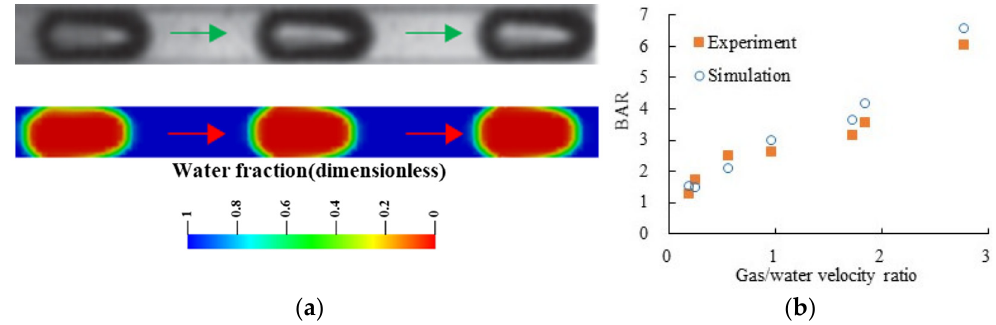
Figure 6. Comparison of the simulation with experimental results for the single-fracture model. ( a ) Comparison of water and gas distribution patterns, with the color bar representing water phase saturation; ( b ) comparison of the BAR.